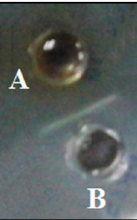
Figure 5. Double diffusion of cationic surfactant ( B ) (positively charged) Cetyl trimethyl ammonium bromide (CTAB) against biosurfactant (BS) ( A ) on agar plate indicating a line of precipitation due to formation of ionic pair.